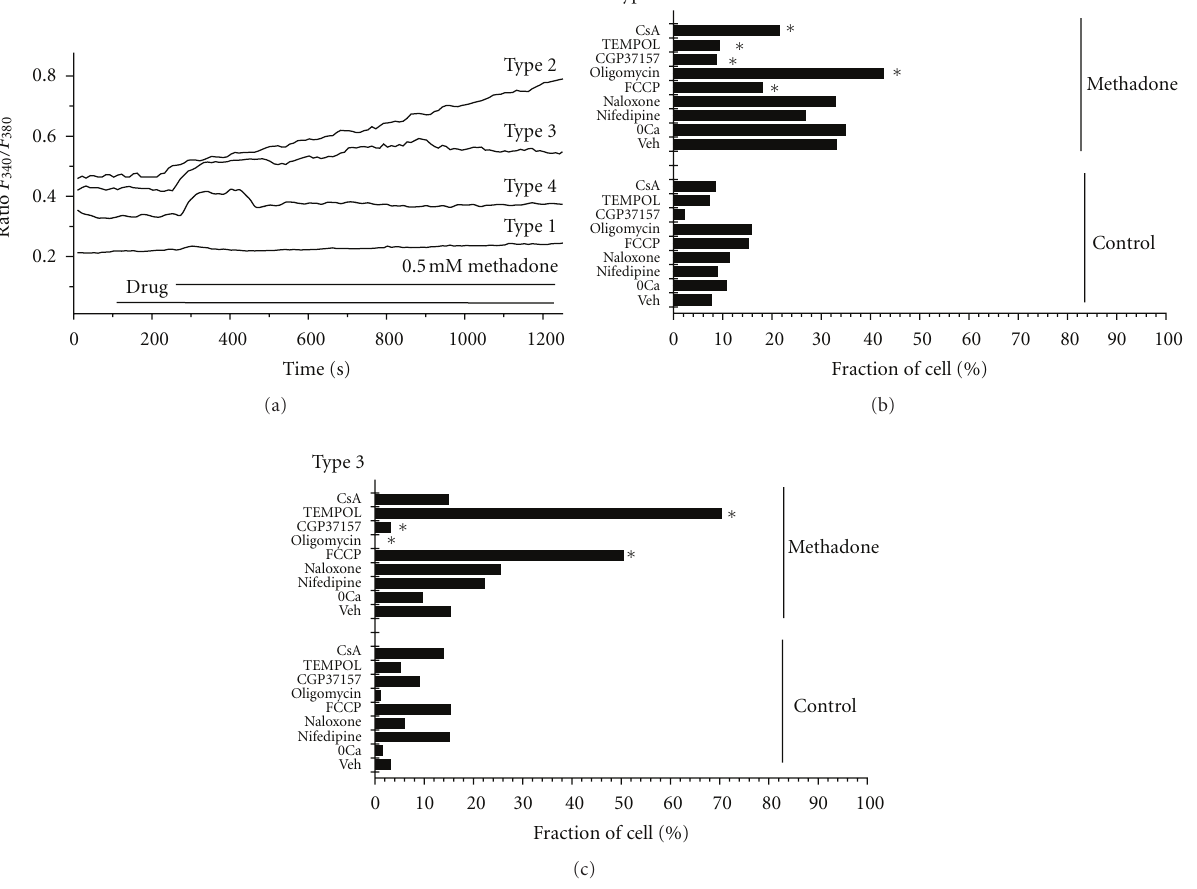
Figure 1: Methadone induces Ca 2+ dyshomeostasis. (a). E ff ects of 0.5mM methadone on [Ca 2+ ] cyt in SH-SY5Y cells. Representative recordings of the four di ff erent types of response including no [Ca 2+ ] cyt increase (type 1), early [Ca 2+ ] cyt sustained increase (type 2), delayed [Ca 2+ ] cyt increase (type 3), and transient [Ca 2+ ] cyt increase (Type 4). (b)-(c)Relative abundance (%) of SH-SY5Y cells that display type 2 (b) or type 3 (c) recordings without (Control) and with methadone treatment (Veh). Also shown are the e ff ects of several treatments on the above mentioned relative abundance. Treatments include removal of extracellular calcium (0Ca), L-type Ca 2+ channel blocker Nifedipine (2 μ M); opioid receptor antagonist Naloxone (50 μ M), mitochondrial uncoupler FCCP (1 μ M); ATP synthase inhibitor oligomycin (10 μ g/ml), mitochondria Na + /Ca 2+ exchanger CGP37157 (25 μ M); superoxide dismutase mimetic TEMPOL (0.2 μ M) or MPTP antagonist cyclosporine A (1 μ M, CsA). All treatments were performed 5 min prior to addition of 0.5 mM methadone. Data represent results obtained in at least 3 independent experiments. ∗ P < 0 . 05; Student’s t -test versus basal conditions,